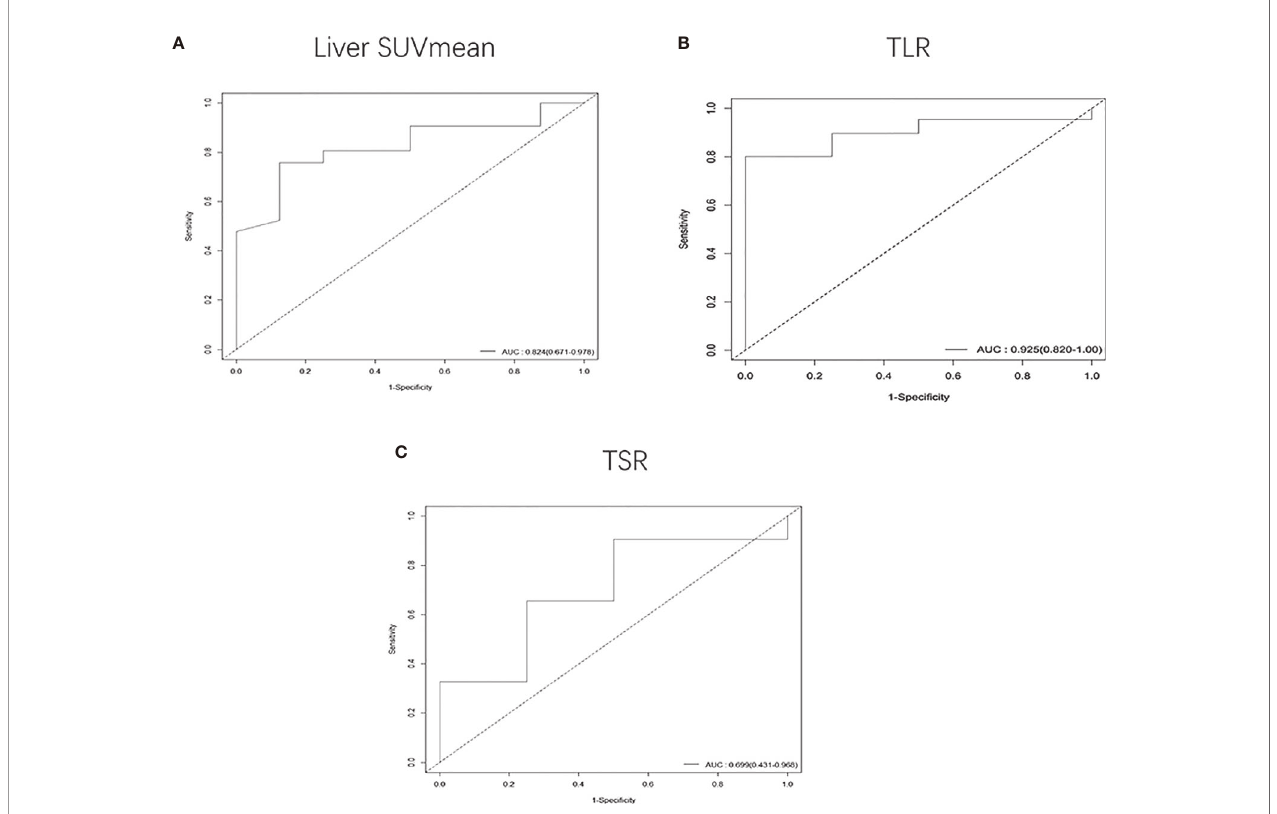
FIGURE 6 | Receiver operating characteristic (ROC) curves were used to compare the liver SUVmean (A) , TLR (B) and TSR (C) of patients whose tumor size was 5-7 cm. The AUCs were 0.824 (95%CI, 0.671-0.978) for liver SUVmean, 0.925 (95%CI, 0.820-1.000) for TLR and 0.699 (95%CI, 0.431-0.968) for